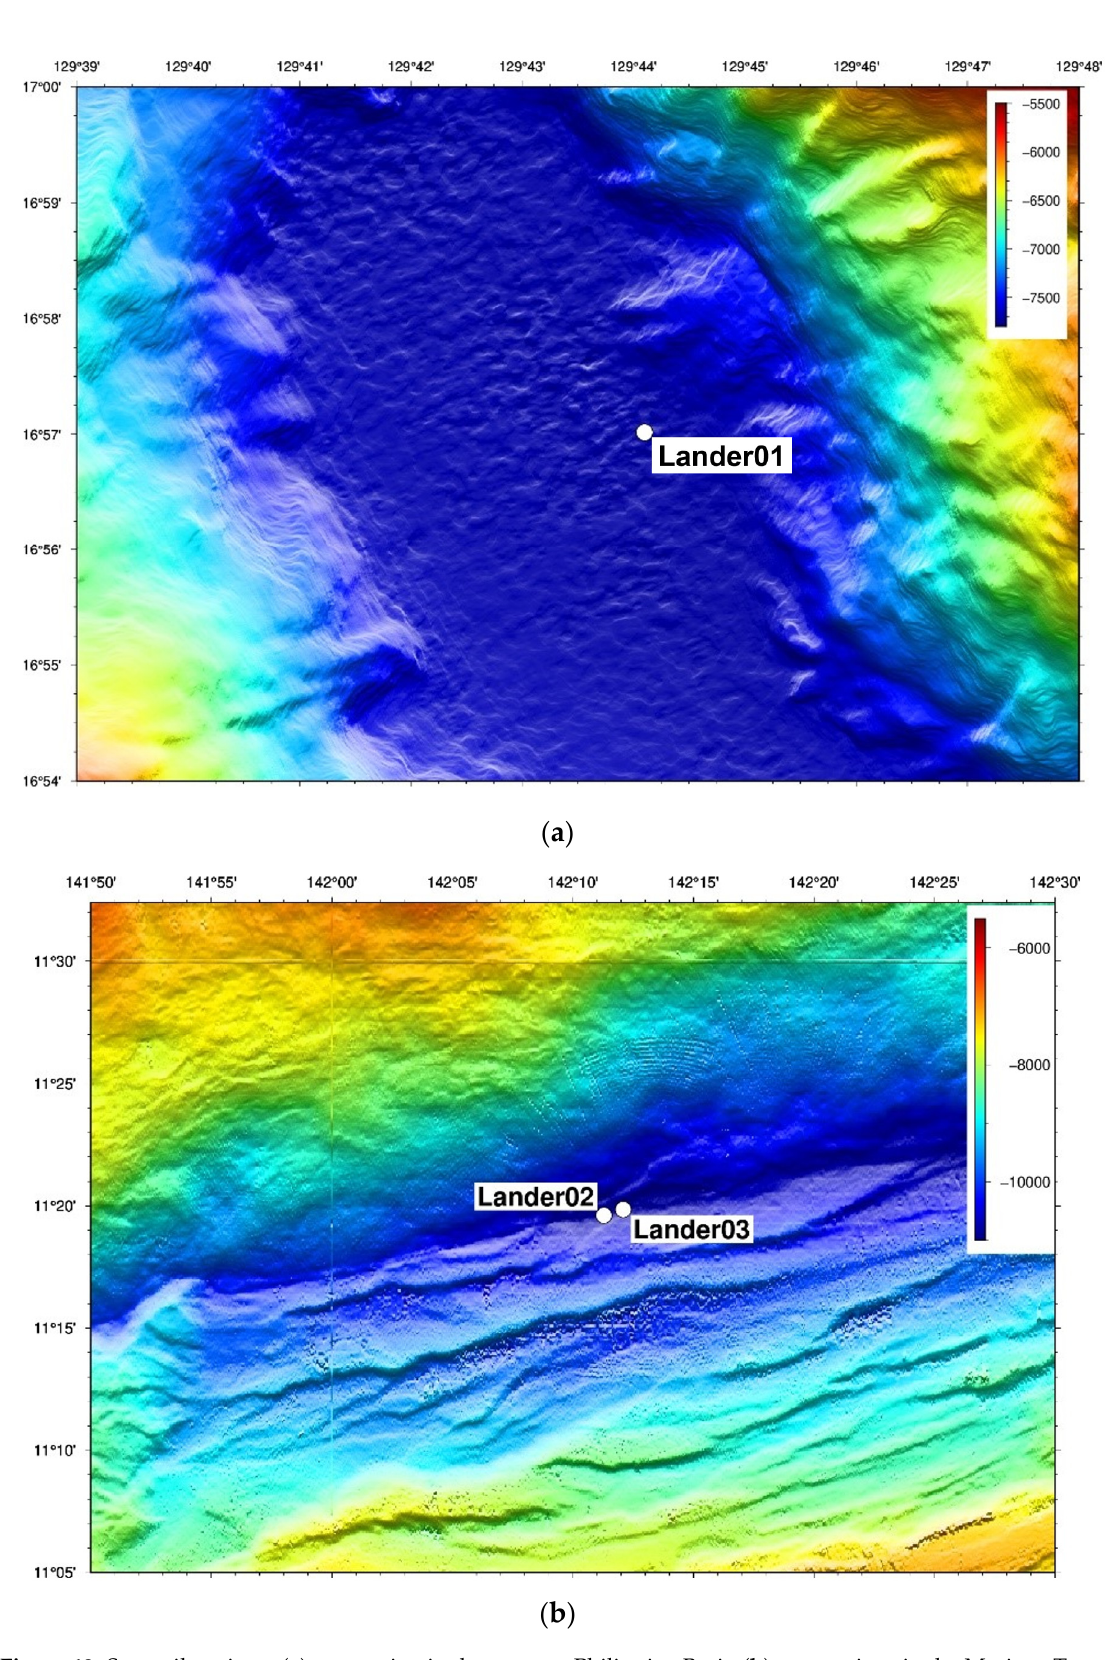
Figure 13. Sea trail stations. ( a ) one station in the western Philippine Basin ( b ) two stations in the Mariana Trench. The field equipment diagram of sea trial as shown in Figure 14 and the sea trial re- sults as shown in Table 4.The in situ multi-stage filtering and preserving device of hadal microorganisms was operated on the seabed for 13 h, and nine samples with different pore sizes were obtained. For the decontamination process, we filled the device with ster- ile water before starting the motor. A check valve was installed at one end of the device.